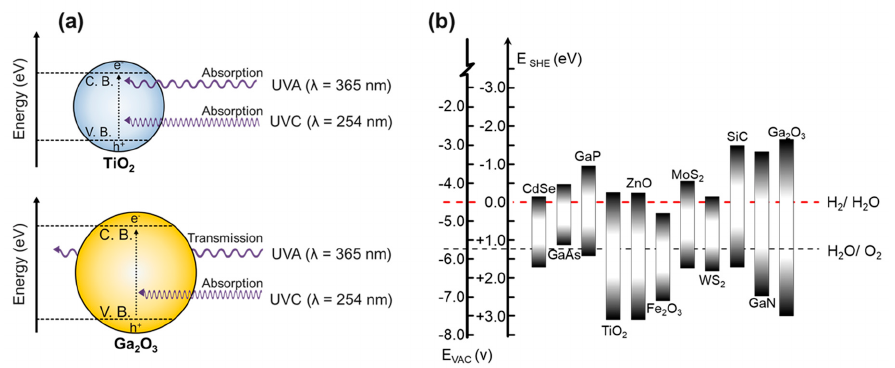
Figure 1. ( a ) UVA and UVC absorption and transmission behaviors depending on the energy bandgap of the semiconductors. ( b ) Correlation between the energy band diagrams of various semiconductors and the redox potential of water splitting [15,16].